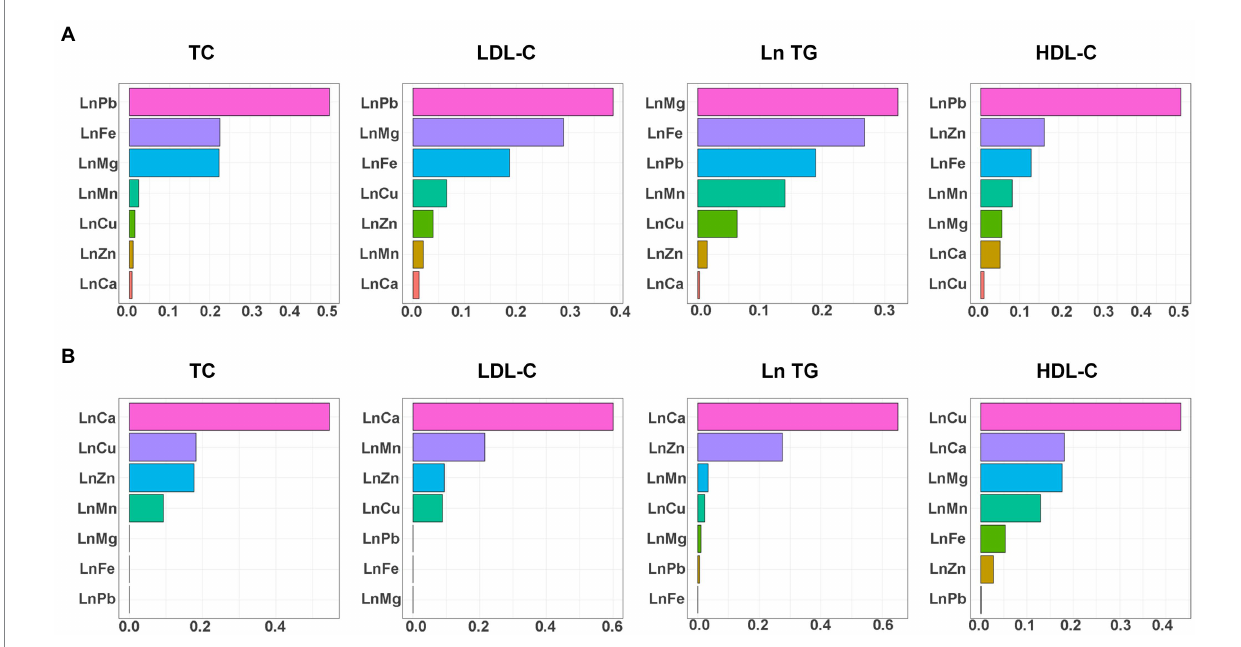
FIGURE 2 WQS regression weights of blood Pb and essential metals for serum lipid profiles. (A) The positive direction and (B) the negative direction. TG, blood Pb and essential metal concentrations were transformed to natural logarithm for further analysis. The model was adjusted for age, sex, educational, smoking status, abuse drinking, BMI categories, diabetes, and hypertension. TC, total cholesterol; TG, triglyceride; LDL-C, low-density lipoproteins cholesterol; HDL-C, high-density lipoproteins cholesterol; BMI, body mass index; Mg, magnesium; Mn, manganese; Ca, calcium; Fe, iron; Cu, copper; Zn, zinc; Pb,